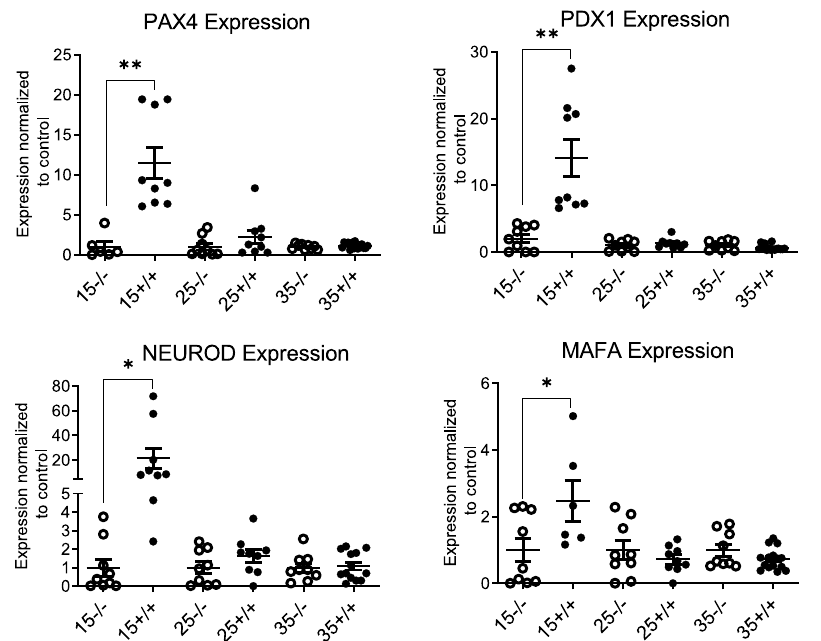
Figure 9. qRT-PCR analysis of BL/6 and BL/6-CD3FLAGmIR mice islet mRNA expression of PAX4, PDX1, NEUROD and MAFA. PAX4 (upper left), PDX1 (upper right), NEUROD (lower left) and MAFA (lower right) islet mRNA expression at 15 ( n = 3 mice with 3 replicates), 25 ( n = 3 mice with 3 replicates) and 35 weeks ( n = 4 mice with 3 replicates) of age. -/- indicates BL/6 mice and +/+ indicates BL/6-CD3FLAGmIR mice. BL/6 and BL/6-CD3FLAGmIR responses are compared to the control, which is the beta-globin housekeeping gene. Unpaired student t test: * p ≤ 0.05, ** p ≤ 0.01.